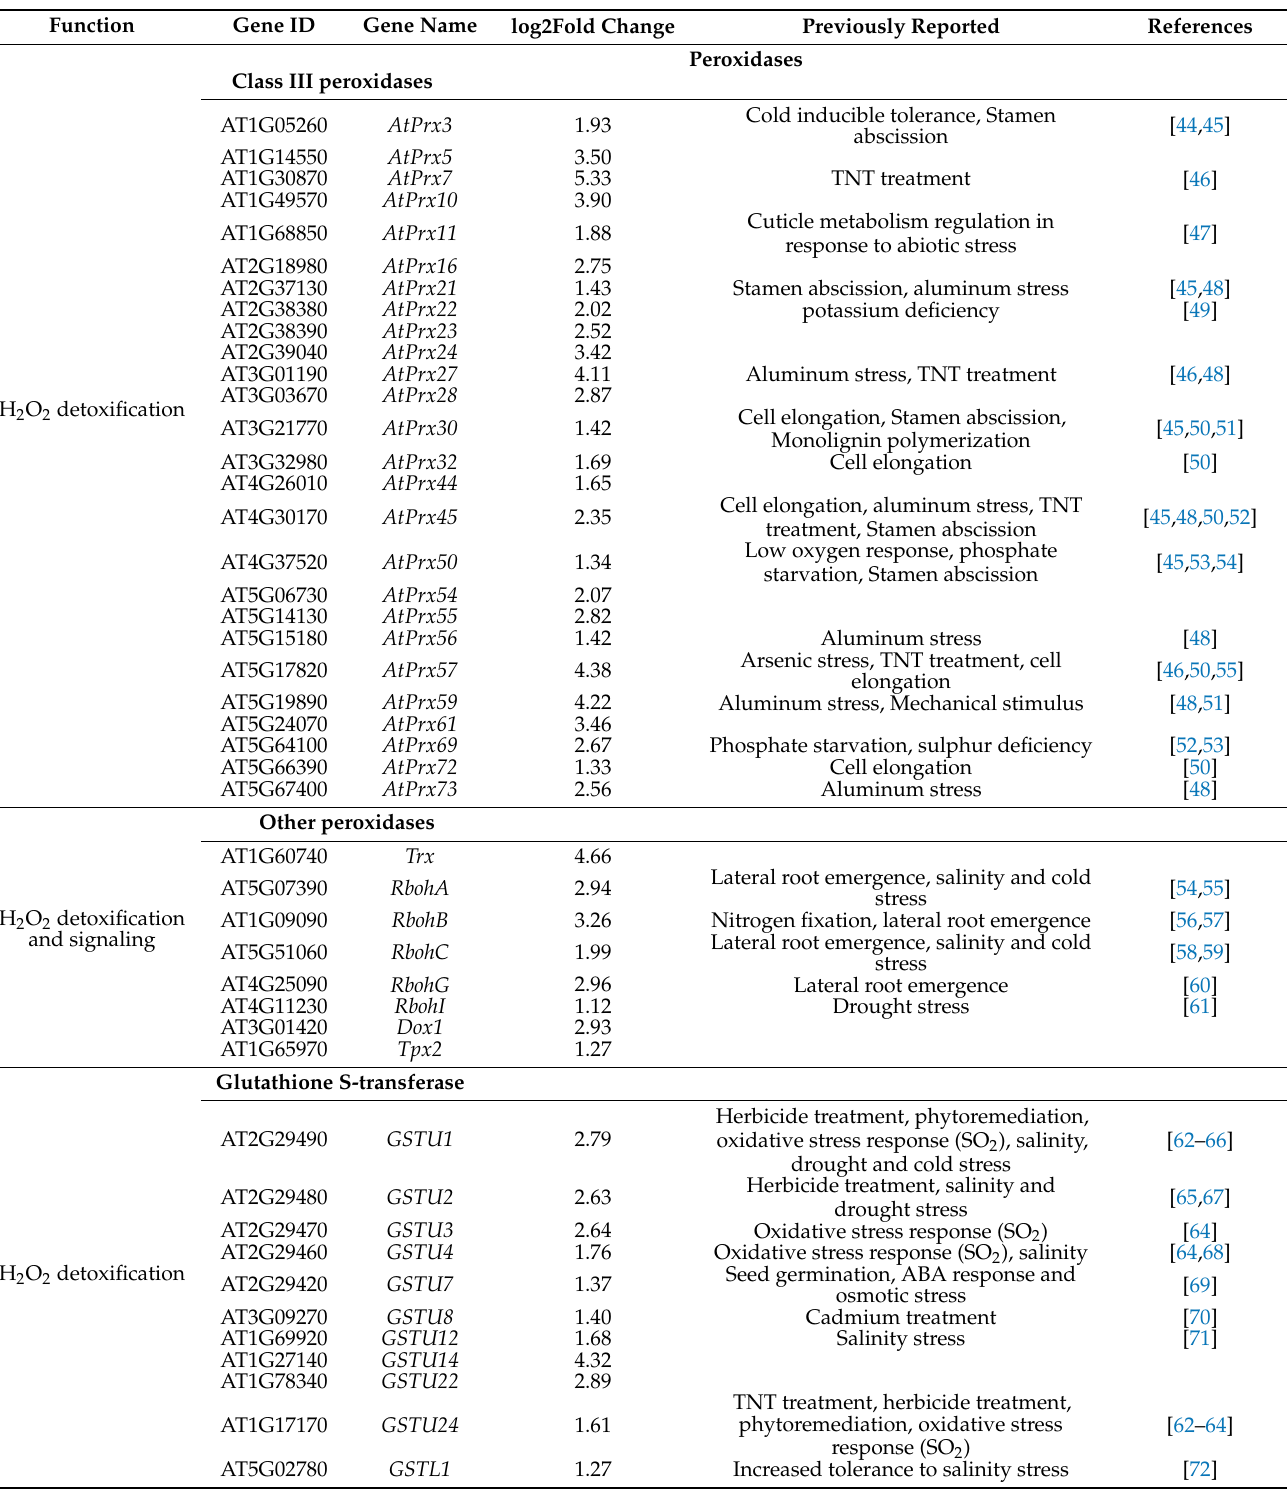
Table 1. List of genes involved in H 2 O 2 detoxification or signaling were more upregulated in Cu-chl NaCl compared to NaCl. AtPrx, arabidopsis thaliana Class III peroxidase; Trx, thioredoxin superfamily protein; Rboh, respiratory burst oxidase homolog/riboflavin synthase-like superfamily protein; Dox, alpha dioxygenase Tpx, thioredoxin-dependent peroxidase; GSTU, glutathione S-transferase class tau; GSTL, glutathione S-transferase lambda; GSTF, glutathione S-transferase class